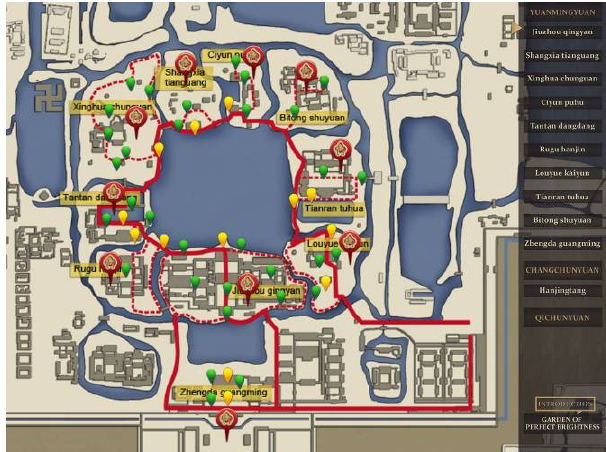
Figure 2. Master plan for Yuanmingyuan in the app, with red lines showing pre-defined visitor route